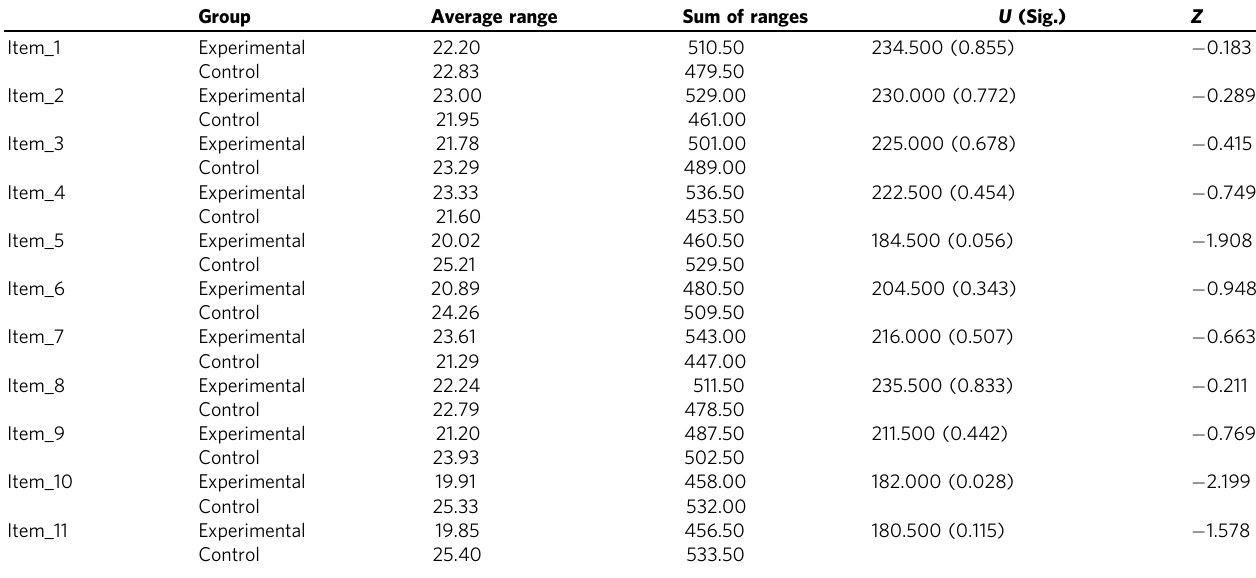
Table 7 Mann – Whitney U test of the pretest between the control group and the experimental group.